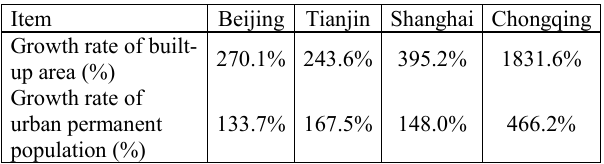
Table 1 . Comparison of the growth of built-up area and the growth of urban permanent population from 1990 to